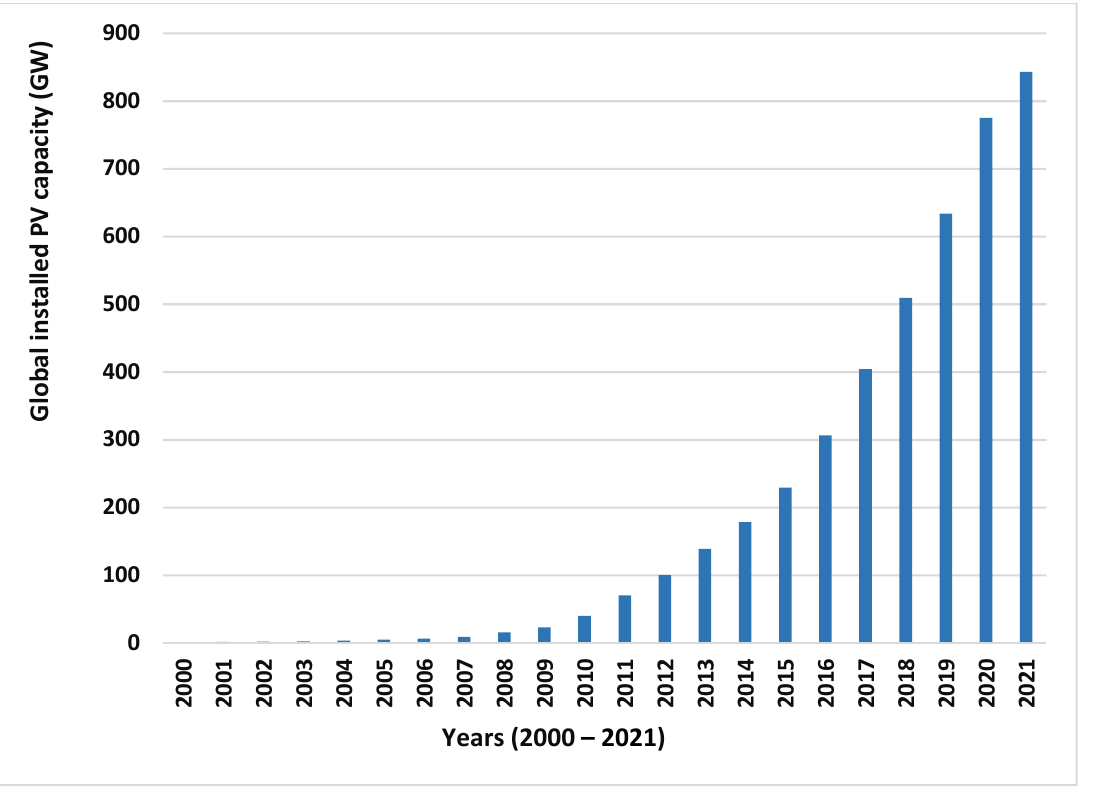
Figure 2. Installed global capacity of PV plants [10].